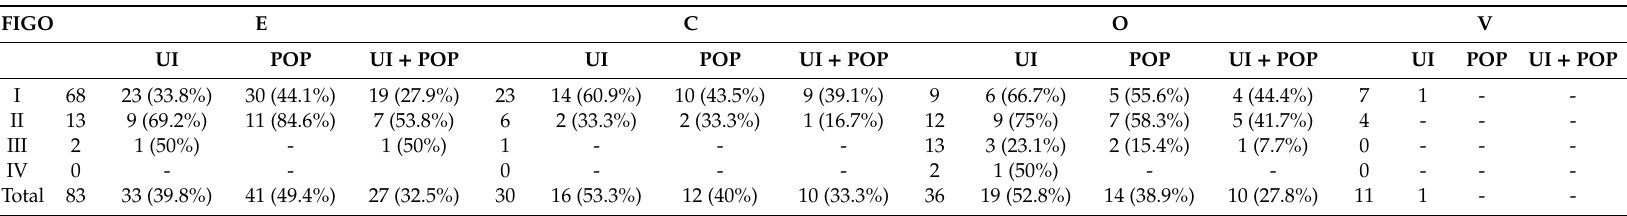
Table 2. Patients’ characteristics according to FIGO staging and type of malignancy considering concomitance of urinary incontinence and pelvic organ prolapse. FIGO